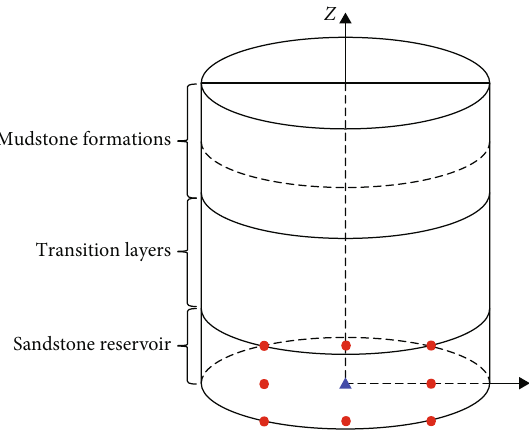
Figure 5: Geological model of the whole lithology in the cylindrical coordinate